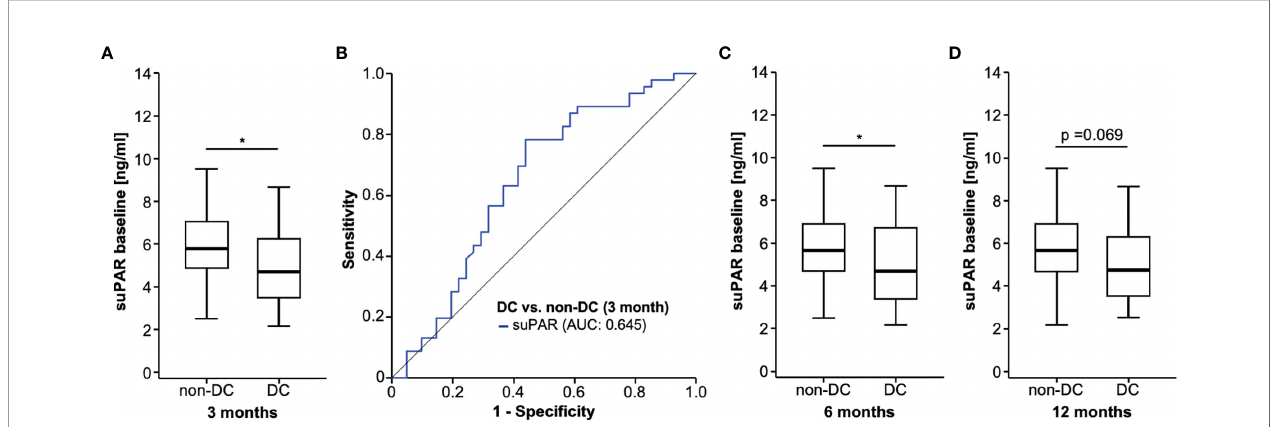
FIGURE 2 | Initial suPAR serum levels predict treatment response to ICI. (A) Patient who show disease control (DC) to ICI at 3 months have signi fi cantly lower baseline suPAR concentrations compared to non-DC patients. (B) ROC curve analysis reveals an AUC value of 0.645 for suPAR regarding the discrimination between DC and non-DC patients. Initial suPAR levels are signi fi cantly lower in patients with DC at 6 months (C) and show a strong trend (p = 0.069), (D) towards lower suPAR levels at 12 months compared to non-DC patients at the respective time points. *p<0.05.